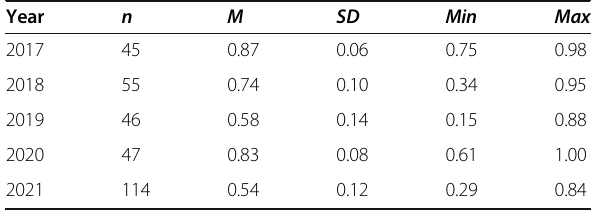
Table 4 Pre-test scores descriptive